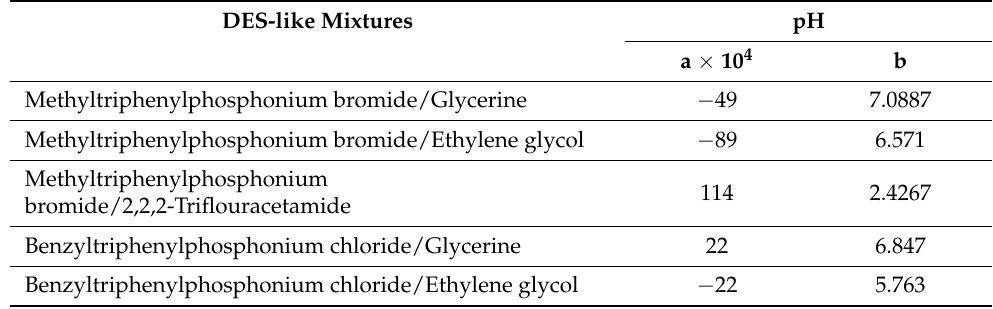
Table 3. Values of constants a and b for Equation (1) (adapted according to Kareem et al.) [26].